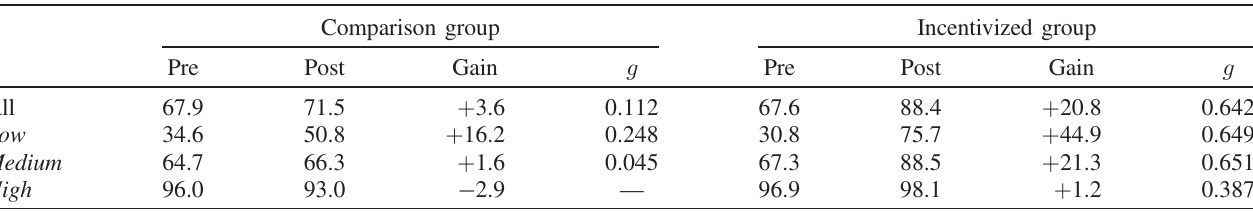
TABLE I. Average pretest and posttest scores, gain and normalized gain ( g ) for students in the comparison and incentivized groups broken down into low, medium and high performance categories based on students ’ pretest score and for all students. While the pretest scores are comparable for the comparison group (number of students N ¼ 33 ) and incentivized group ( N ¼ 31 ), the posttest scores are significantly higher for the incentivized group (reflected in gain and g ). The numbers of students in the low, medium and high performance categories are 8, 14 and 11, respectively, in the comparison group, and 7, 15, and 9, respectively, in the incentivized group. Comparison